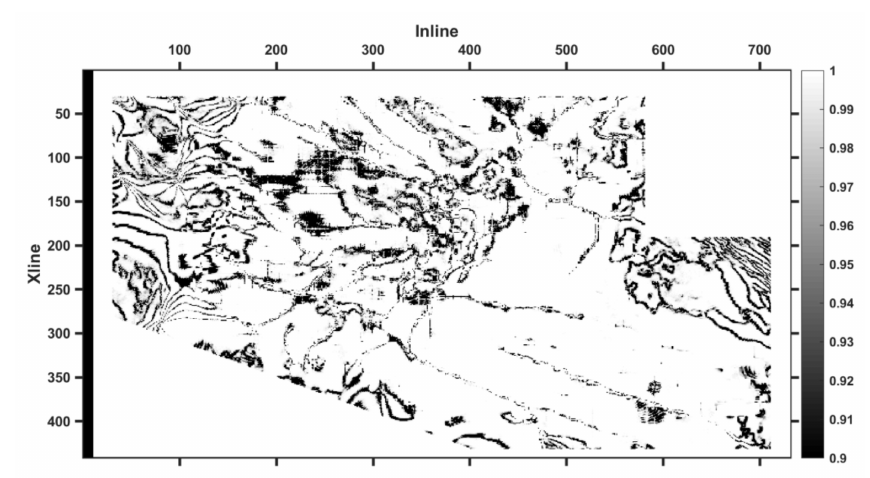
Figure 11. The waveform difference attribute of the coal seam. 3. Instantaneous frequency. Instantaneous frequency is the seismic attribute obtained by sampling the midpoint, one by one, according to the frequency of the trace set, revealing the fault at the local extremum. In Figure 12, the boundary, marked by an abrupt change in tone, is the theoretical fault development position, which can better identify the small fault and improve its multi-solution